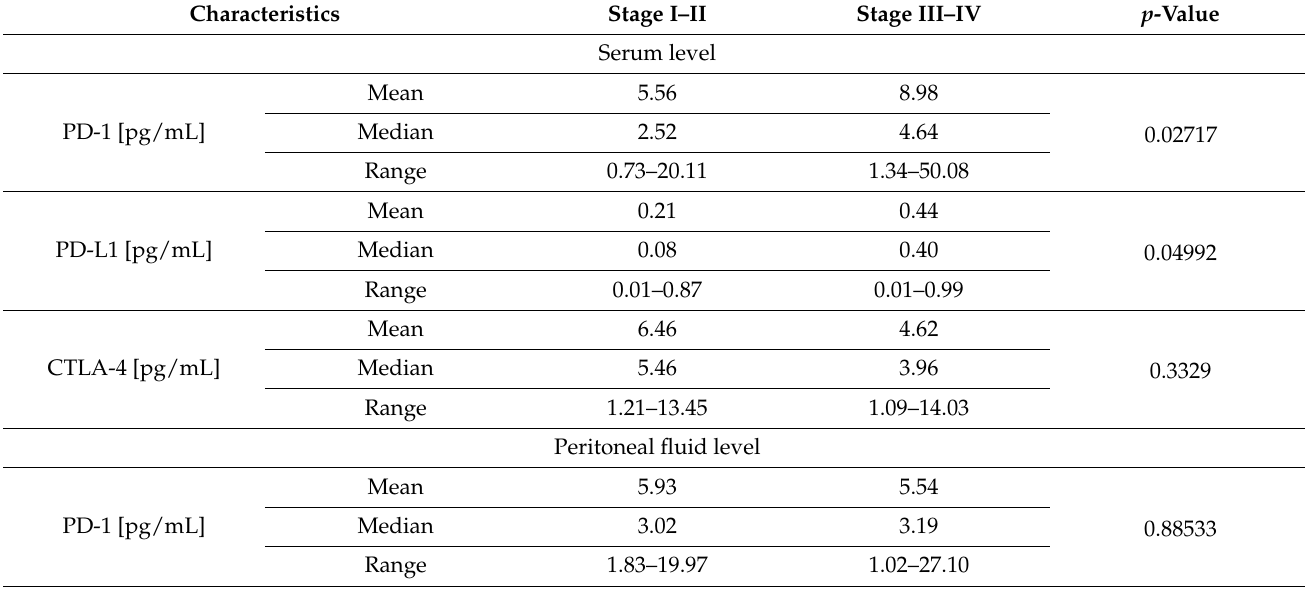
Table 4. Levels of serum and peritoneal fluid concentrations of the studied proteins in the compared tumor FIGO stage